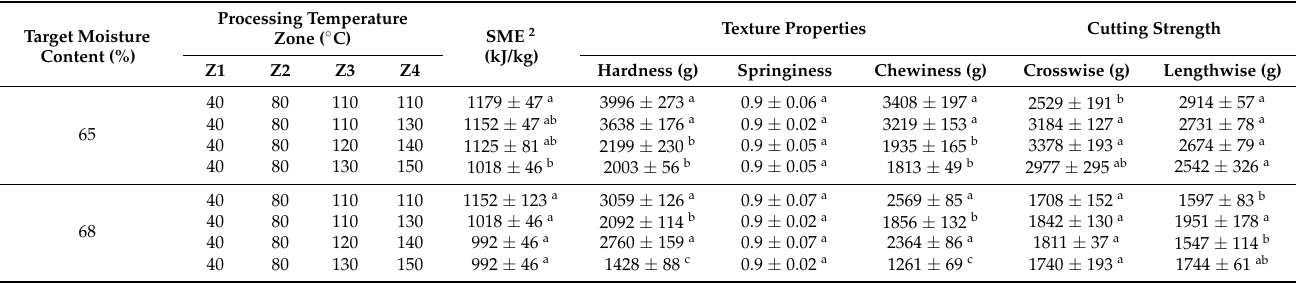
Table A2. Texture properties of high-moisture meat analogue (HMMA) made from commercial yellow pea protein isolate during preliminary extrusion temperature trials 1 (total mass flow 3 kg/h; screw speed 800 rpm). Target Moisture Content